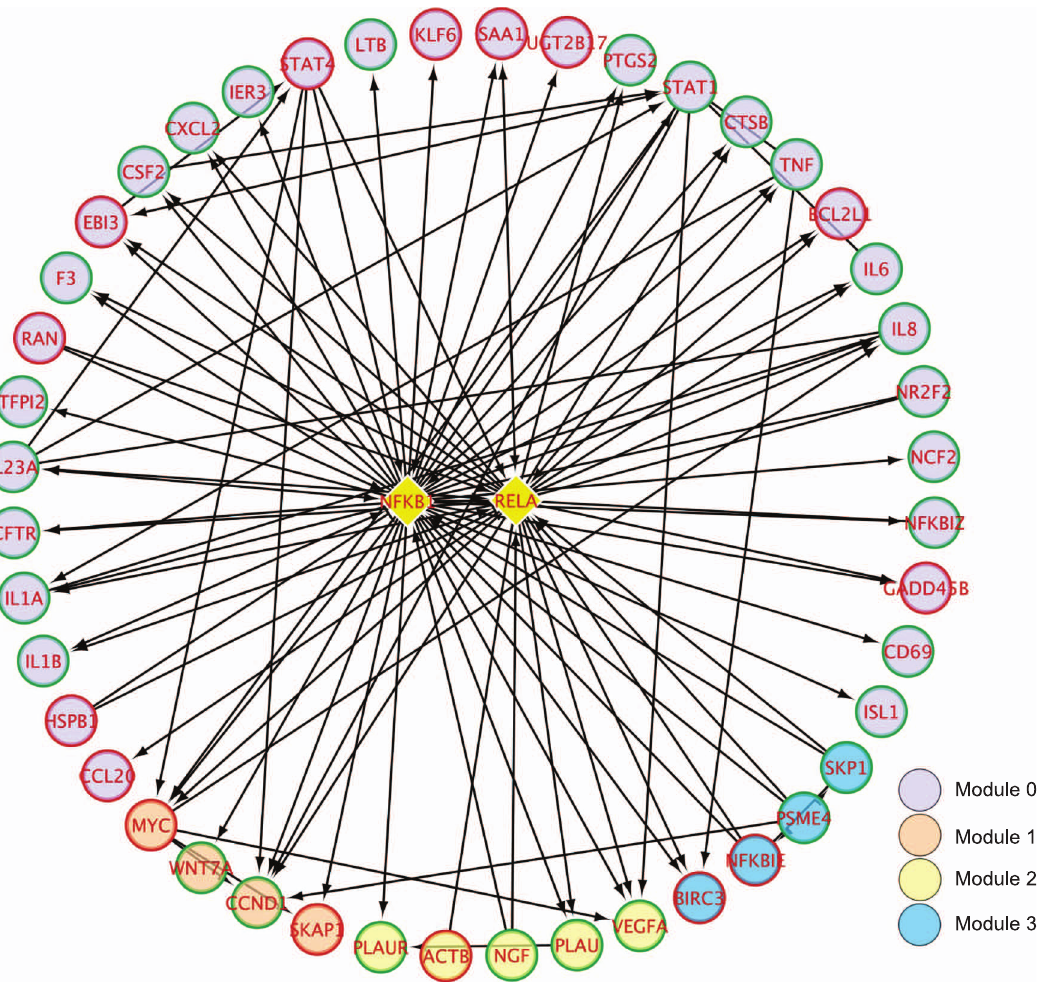
Figure 4. DEX affected NF k B target genes and interacting proteins across four network modules identified by network-based analysis. Genes up-regulated by DEX are depicted by red outer circles, whereas genes down-regulated by DEX are depicted by green outer circles. NF k B subunits are depicted by yellow diamonds. Direct activating or inhibitory interactions are indicated with the symbols R and -|, respectively. Indirect interactions involving additional proteins are depicted with dashed lines.